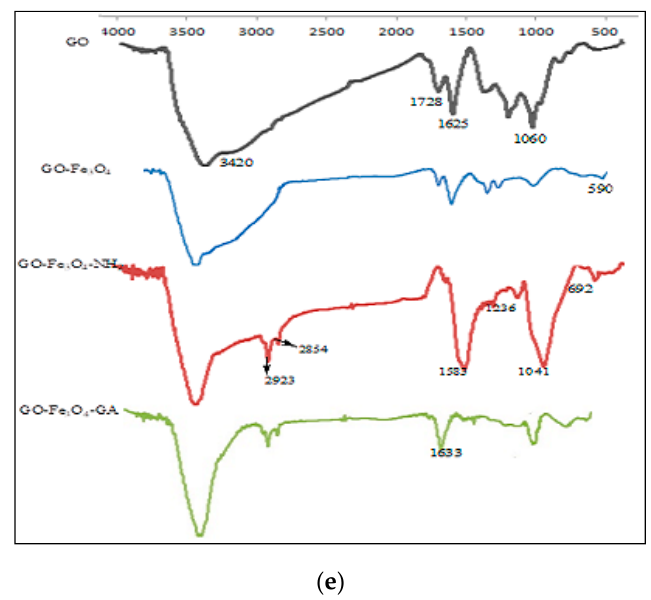
Figure 2. SEM micrographs of ( a ) Fe 3 O 4 / GO and ( b ) Lac / Fe 3 O 4 / GO. ( c ) EDX spectrum of Lac / Fe 3 O 4 / GO. ( d ) Magnetic curves of Fe 3 O 4 / GO and Lac / Fe 3 O 4 / GO at room temperature. ( e ) FT-IR spectra of GO, Fe 3 O 4 / GO, NH 2 / Fe 3 O 4 / GO, GA / Fe 3 O 4 / GO.